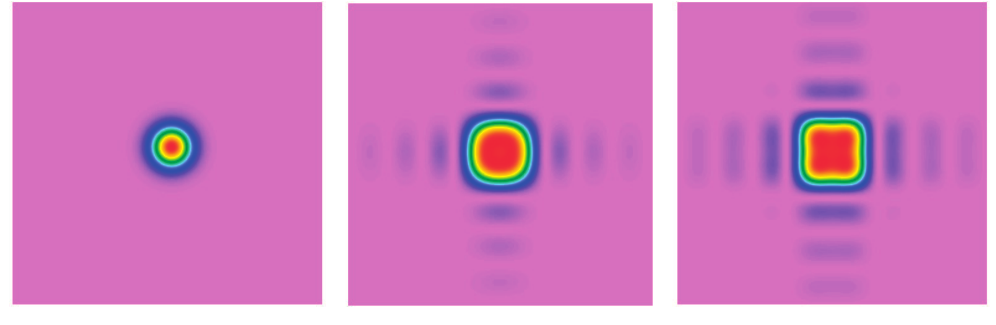
Figure 2. Calculated intensity distribution of the focus beam shaper 1 (FBS-1) ( middle ) and FBS-2 ( right ) Top-Hat beam profile in comparison to a Gaussian beam profile ( left )